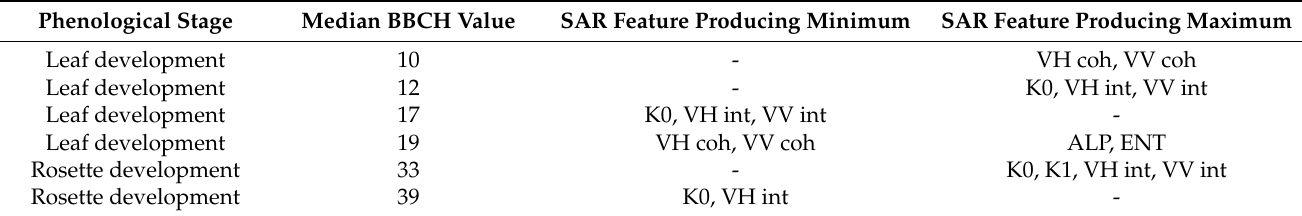
Table 8. Summary of relevant extrema and corresponding BBCH values for sugar beet